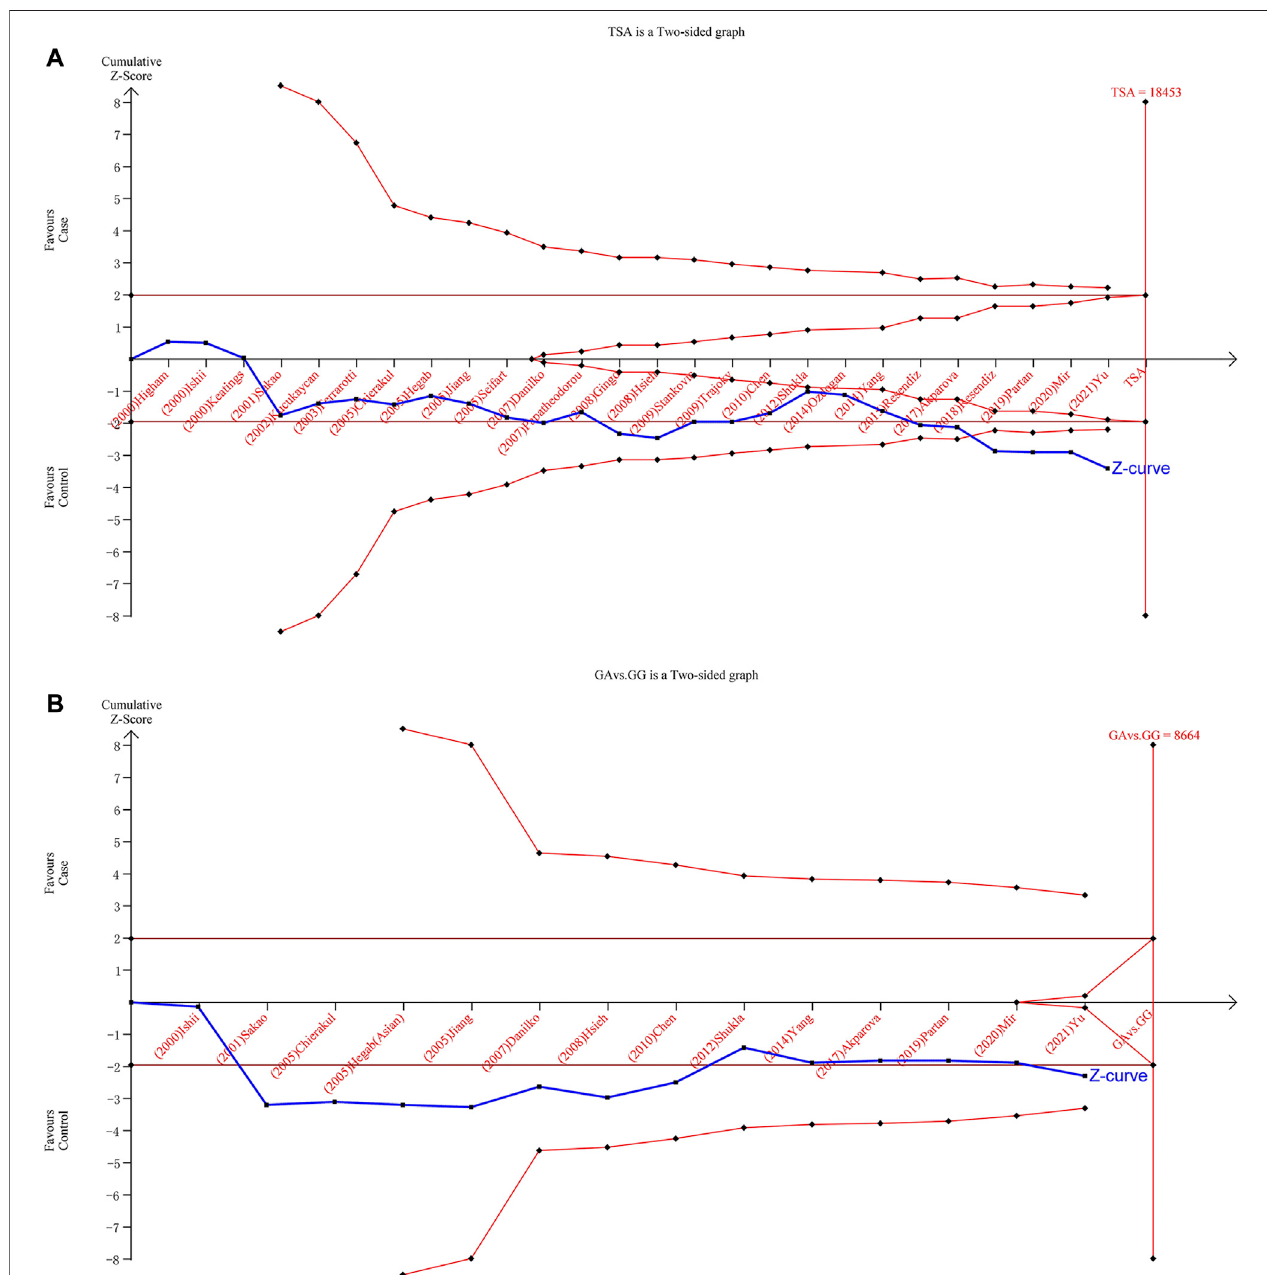
FIGURE5| ResultsofTSAwithTNF- α -308variant.Therequiredinformationsizewascalculatedbasedonatwo-sided a (cid:1) 5%, ß (cid:1) 15%(power80%),andarelative risk reduction of 20%. [ (A) : overall for A vs. G, (B) : Asian population for GA vs. GG].